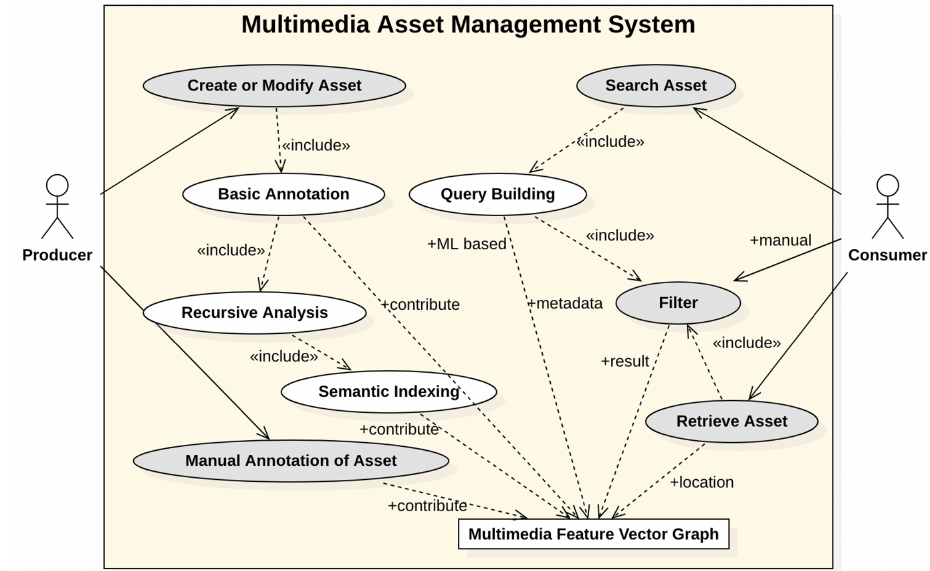
Figure 2. Initial use case design to extend a multimedia asset management